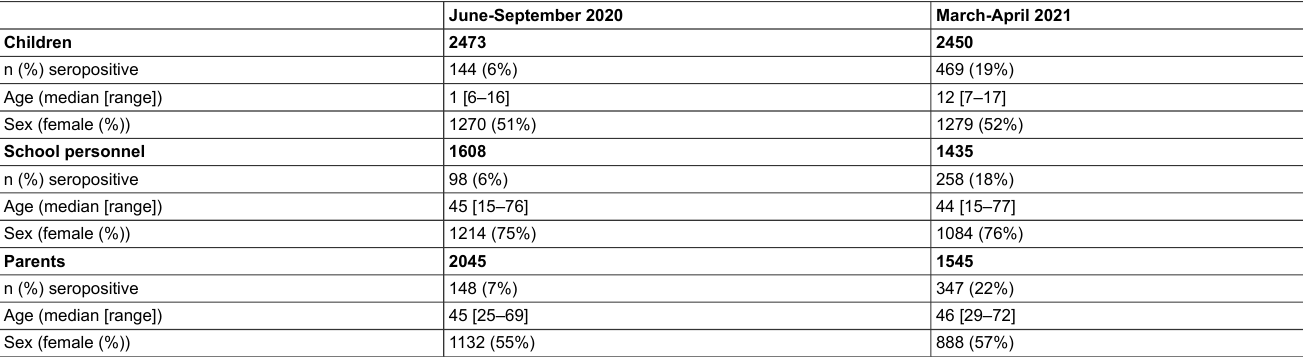
Table 1: Characteristics of the children, school personnel and parent participant cohorts in June-September 2020 and March-April 2021.